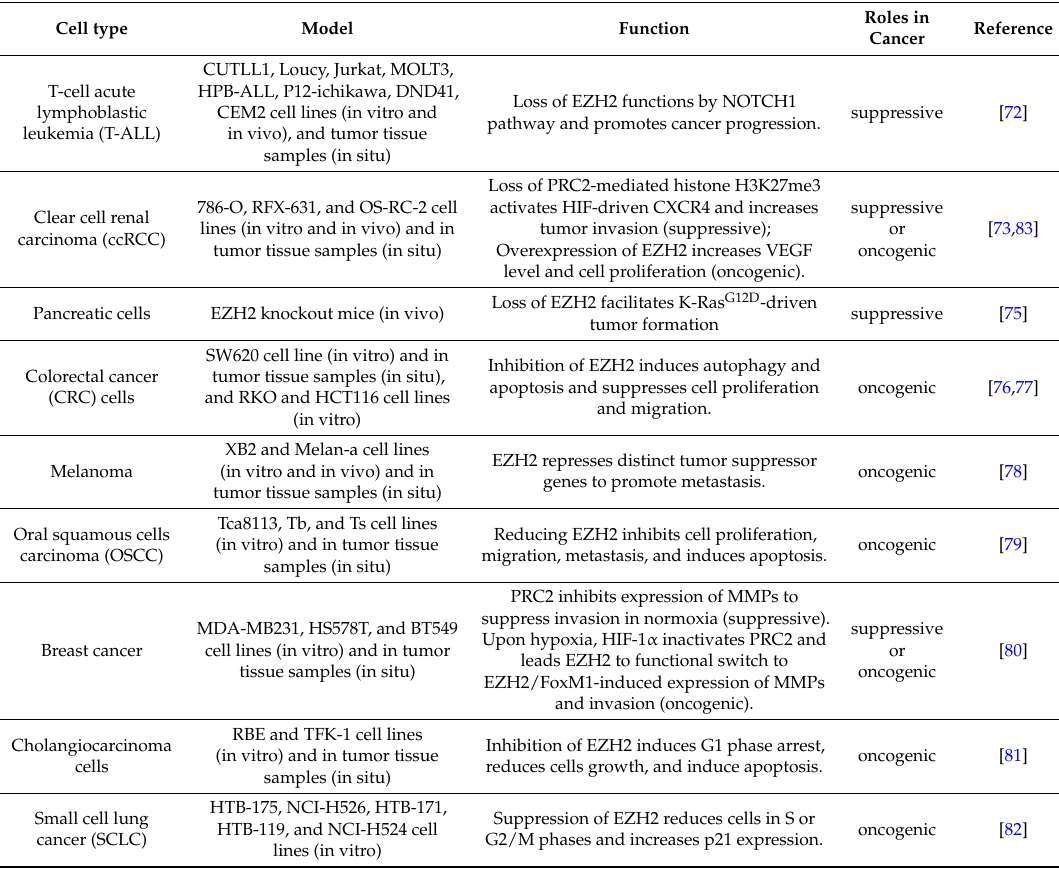
Table 4. Roles of EZH2 in cancer progression.